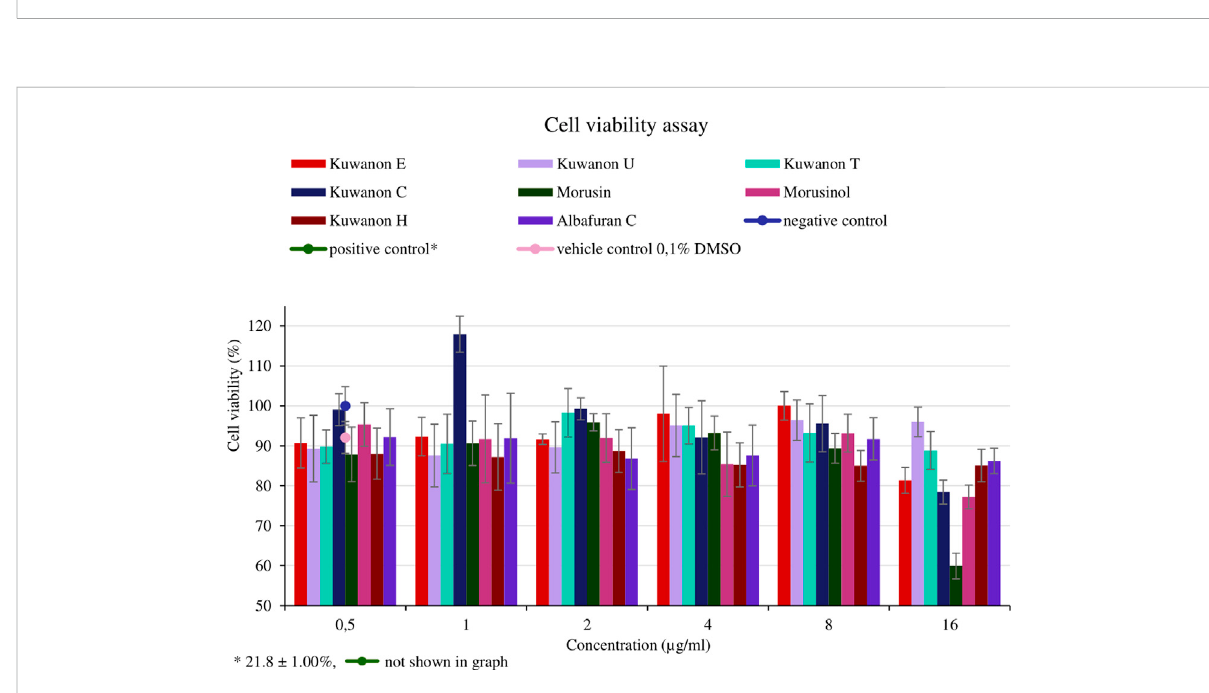
FIGURE 3 Minimum inhibitory concentrations (MICs) of (A) EtBr, ethidium bromide; (B) CIP, cipro fl oxacin and (C) NOR, nor fl oxacin alone, and in combination with the standard inhibitor CCCP, carbonyl cyanide m -chlorophenylhydrazone; CPZ, chlorpromazine; reserpine; verapamil and kuwanon C against MRSA 7109 shown in μ